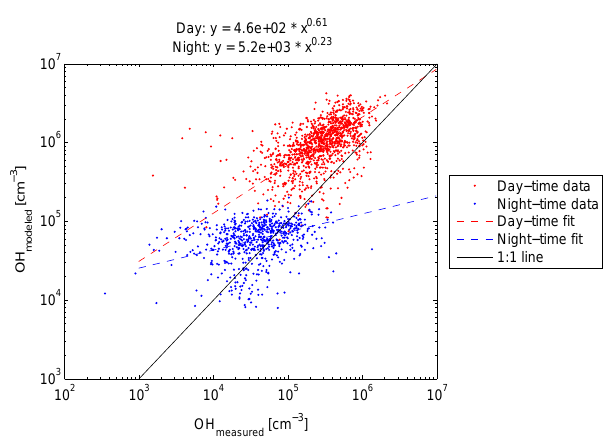
Fig. 8. Correlation and bivariate fits of measured and modeled hydroxylradical concentrations forday-time (red) andnight-time (blue) data. Black line is 1:1 line, red and blue lines are fitted to the data sets.